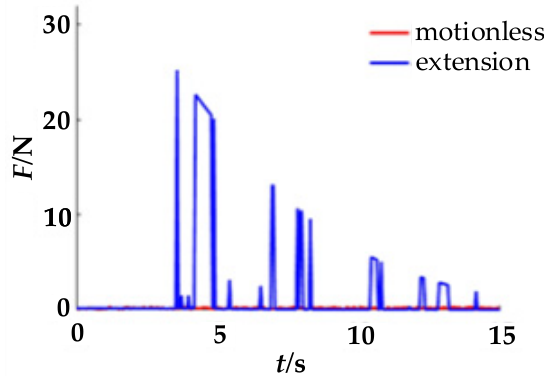
Figure 5. Upper-side piezoelectric signal.